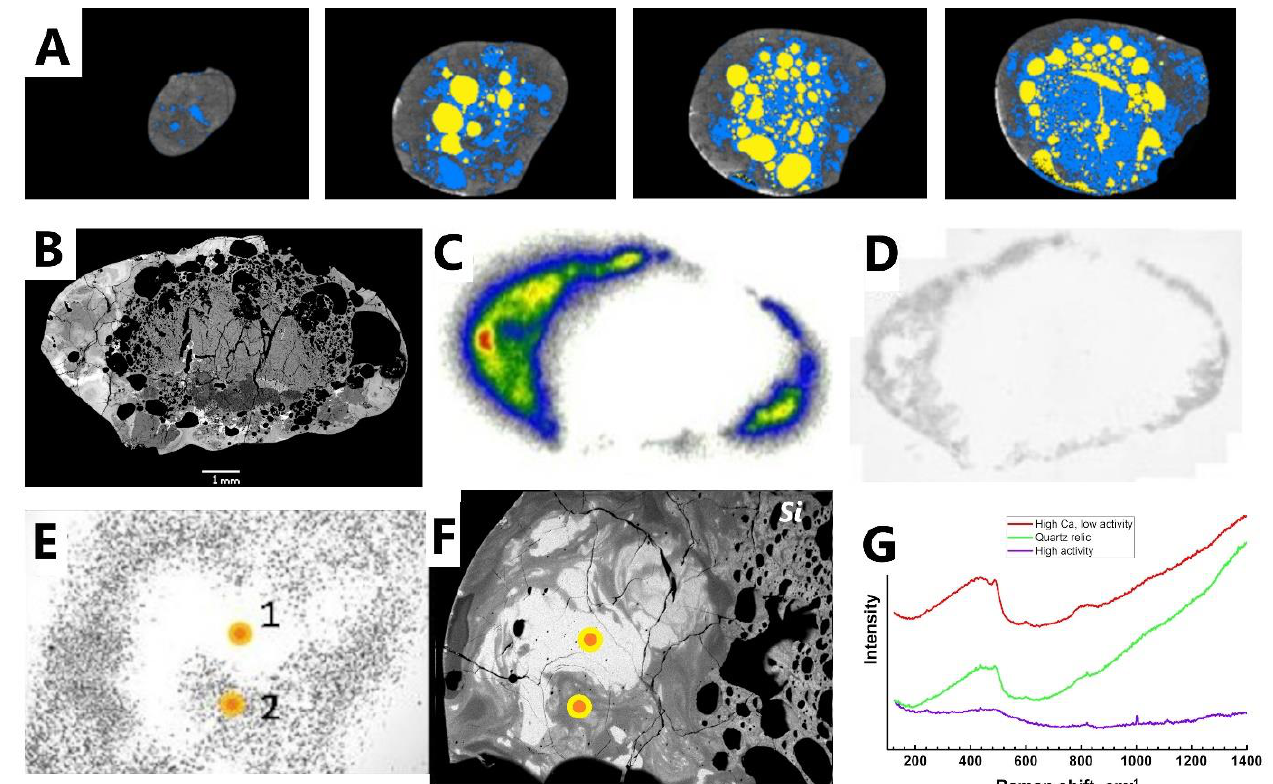
Figure 5. Structural features of the nuclear melt glassy fragments of Group II. ( A ) X-ray tomography slices of the particle Kh-2 with several phases of different density: glassy phase (grey), sintered sand (blue), and bubbles (yellow); ( B ) SEM-BSE image of the cross-section of the Kh-7b; ( C , D ) radiography of the cross-section of the Kh-7b: ( C ) —β -activity distribution on the imaging plate radiogram (6 days exposure); ( D ) α -track radiograph of the cross-section Kh-7b (6 days exposure); ( E – F ) a fragment of glassy shell of the particle Kh-7b: ( E ) α -track radiograph; ( F ) — Si map (SEM-EDX); (G) Raman spectra of points marked on ( E ) and ( F ).